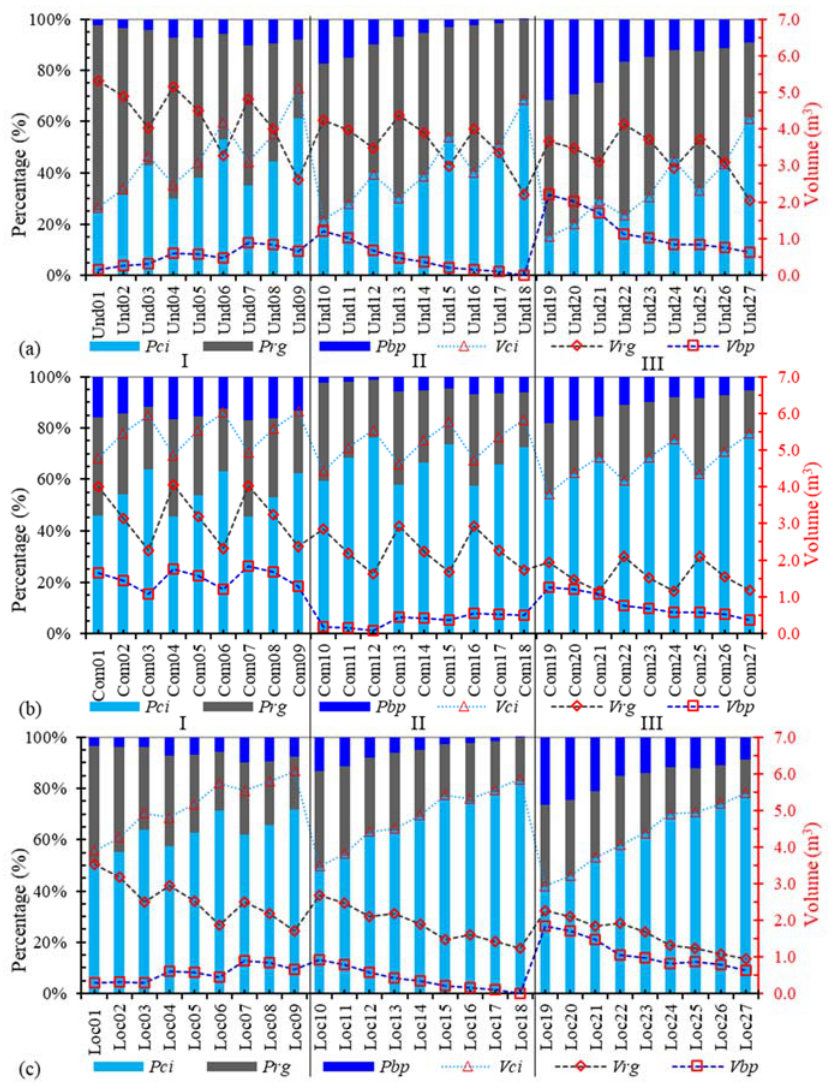
Figure 5. Runoff volume and percentage of curb inlet intercepted, grate inlet captured, and road end bypass flow for RB stripe with undepressed curb inlet ( a ), composite depressed curb inlet ( b ), and local depressed curb inlet ( c ), group I for results with S 0 = 0.001, group II for results with S 0 = 0.003, and group III for results with S 0 = 0.007. The grate inlet captured runoff percentage ranges from 28.09% (Und27) to 73.35% (Und01) with average ± standard deviation of 51.48 ± 11.22% for undepressed cases, from 15.90% (Com21) to 55.66% (Com04) with 32.26 ± 11.66% for composite slope cases, from 12.90% (Loc27) to 48.56% (Loc01) with 27.72 ± 8.74% for local depressed cases. The road end bypass runoff percentage ranges from − 12.32% (Und07) to 30.32% (Und19) with average ± standard deviation as 5.44 ± 11.53% for undepressed cases, from − 25.42% (Com07) to 17.45% (Com19) with − 4.97 ± 13.32% for composite slope cases, from − 12.32% (Loc07) to 25.51% (Loc19) with 4.51 ± 10.42% for local depressed cases. It is indicated that the grate inlet capacity was large enough to capture the upstream and downstream inflow for that the road end bypass flow of some cases is negative. Therefore, the grate inlet captured runoff percentage was limited by the upstream and downstream inflow rather than by the grate inlet capacity when combined with the curb